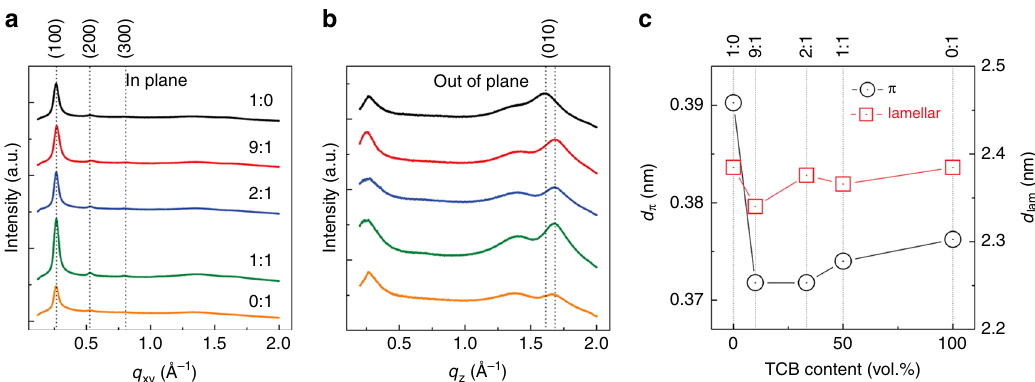
Fig. 5 Grazing incidence wide-angle X-ray scattering (GIWAXS) of thin fi lms. GIWAXS of D-PDPP4T-HD thin fi lms cast from different chloroform:1,2,4- trichlorobenzene (CF:TCB) solutions. a In-plane pro fi le. b Out-of-plane pro fi le. c Lamellar spacing ( d lam ) and π -stacking distance ( d π ). Note that the scale in panel c is different for d π and d lam